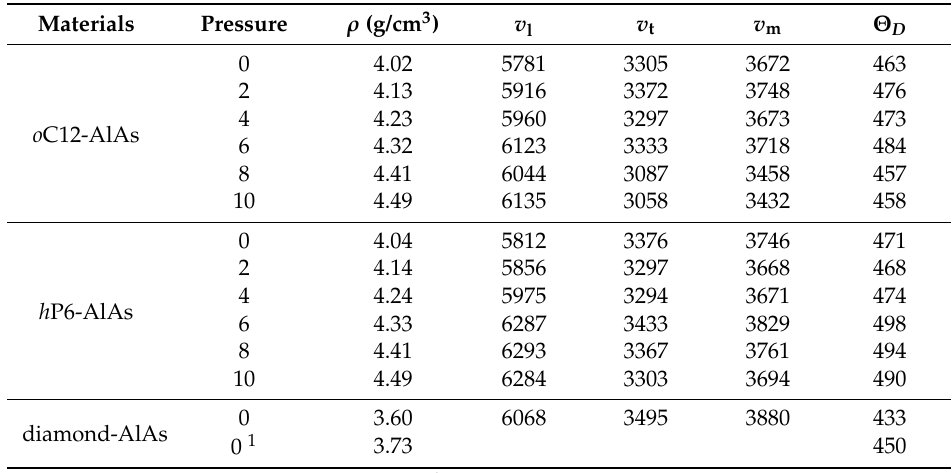
Table 4. The density ( ρ in g/cm 3 ), sound velocity ( v l , v t , v m , in m/s), and Debye temperature ( Θ D in K) for o C12-AlAs, h P6-AlAs, and diamond-AlAs under